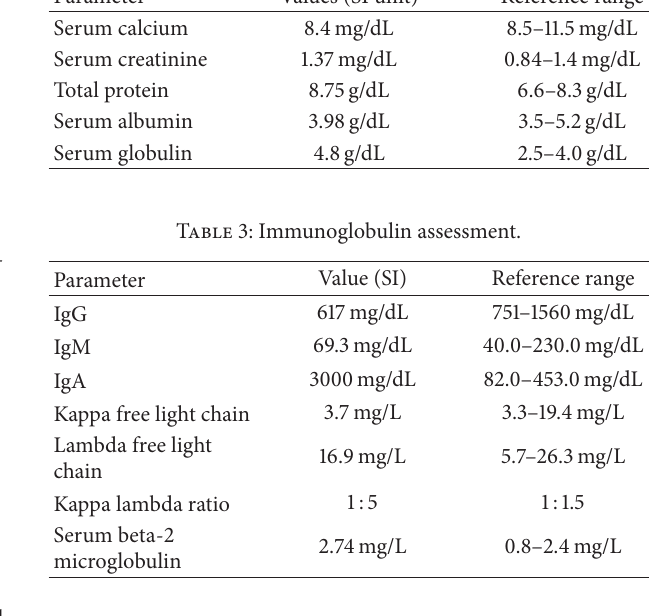
Figure 2: Intraoral examination reveals a normal mucosa and dentition. Table 1: Hematological investigations.